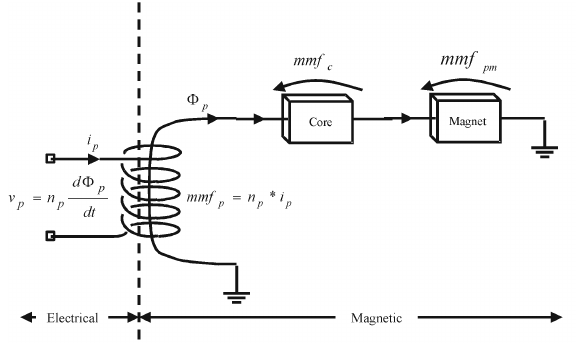
Figure 1: Fault Current Limiter Operating Regions